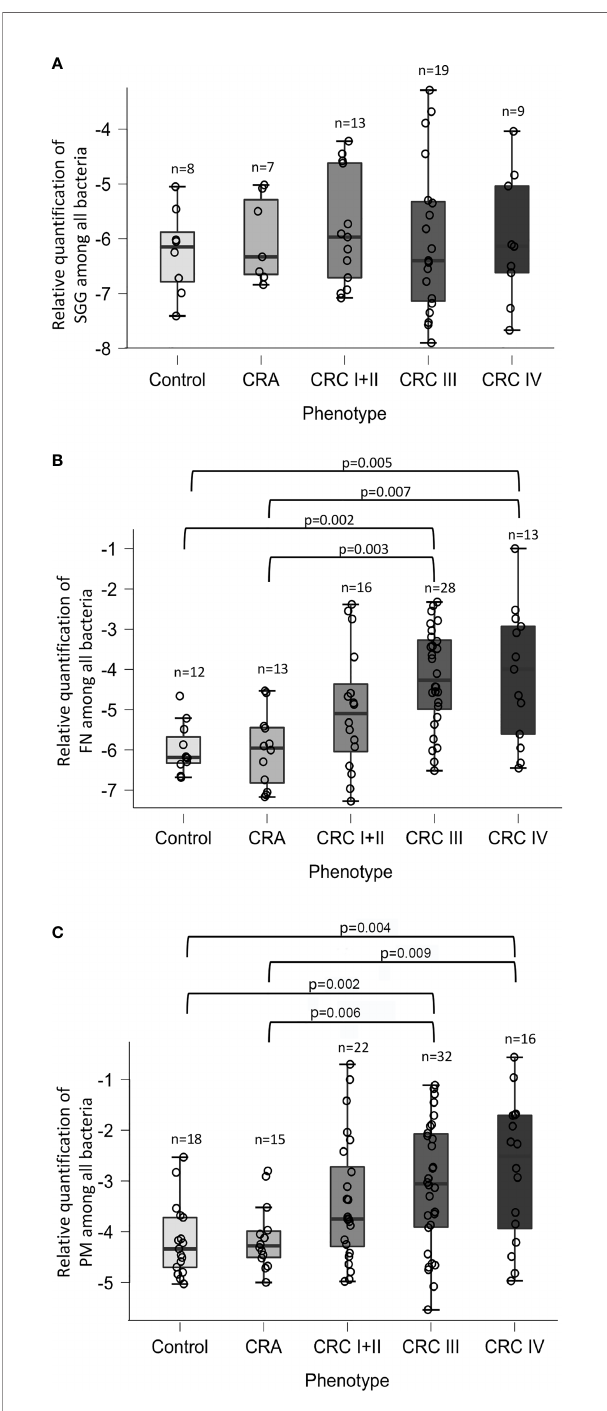
FIGURE 2 | Relative quanti fi cation of Streptococcus gallolyticus ( SGG ), Fusobacterium nucleatum (FN), and Parvimonas micra (PM). The levels of (A) SGG , (B) FN, and (C) PM in control, adenomatous (CRA), or patients at each stage of colorectal cancer (stage I or II, stage III or IV) were calculated as a relative quanti fi cation of bacteria among total bacteria [log 10 (2 − (CqBacteria − CqAllBacteria) )] using the 16S rRNA gene as a reference. Statistical signi fi cance was calculated using the non-parametric Mann – Whitney U test. The real p -value is indicated for groups displaying signi fi cant